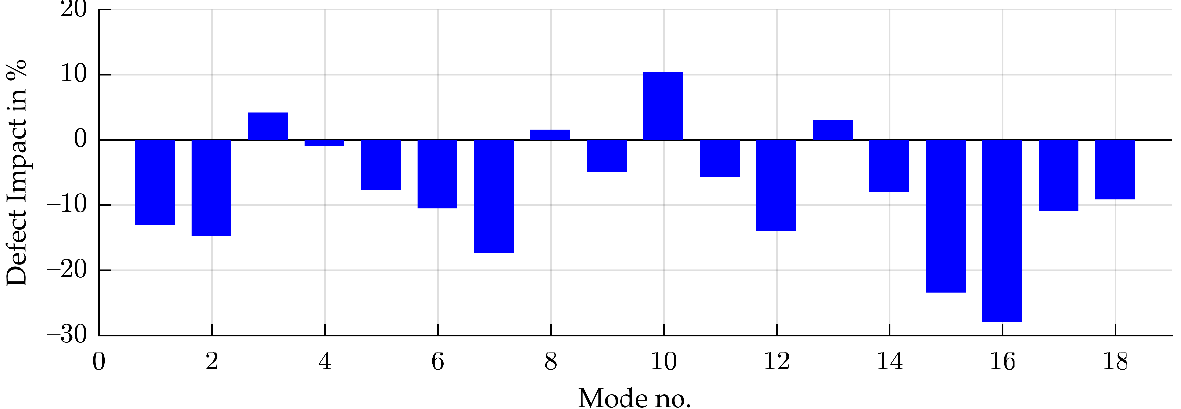
Figure 6. Relative defect sensitivity to a central 2 mm defect in a connecting rod (the relative defect sensitivity is the ratio of the defect impact and the geometry-induced standard deviation).